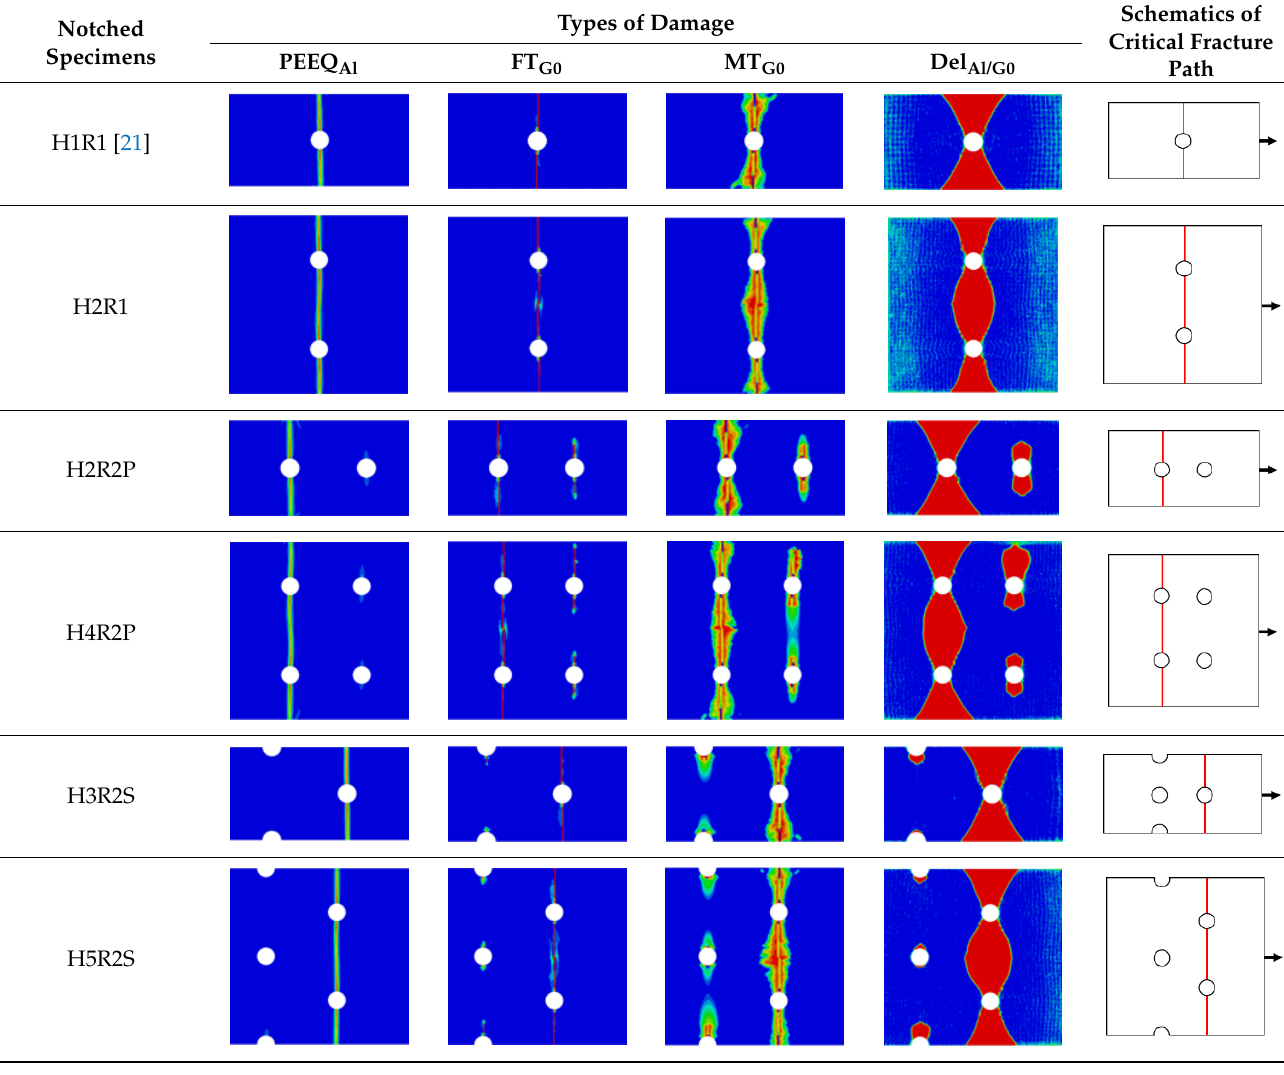
Table 7. Damage patterns of on-axis Glare with different hole arrangements.